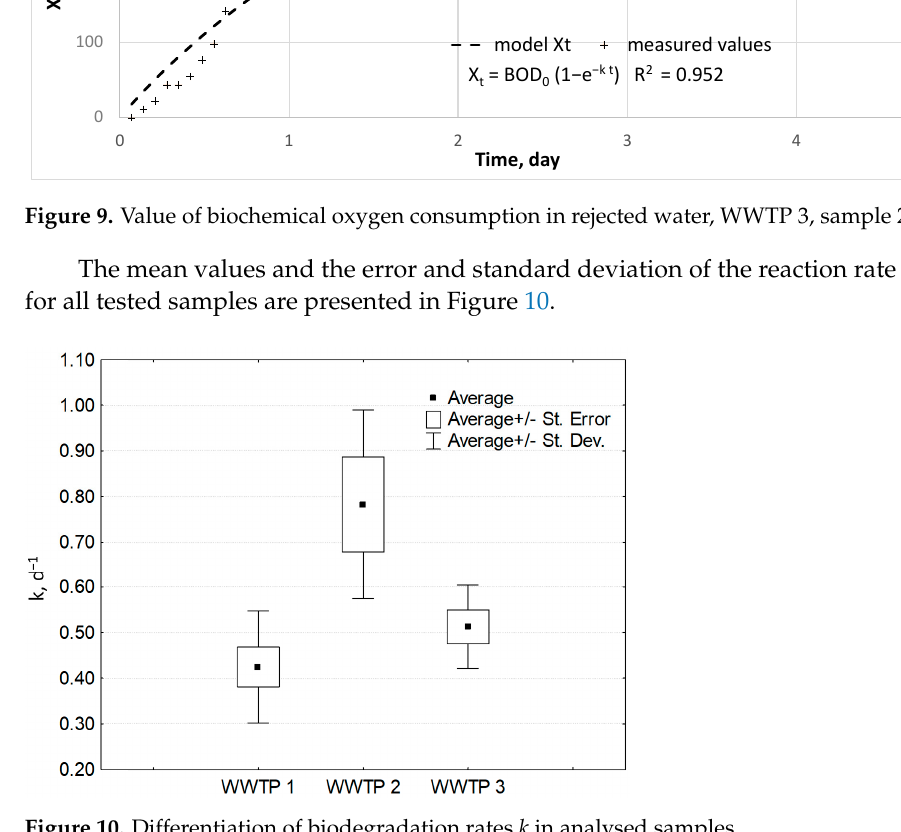
Figure 10. Differentiation of biodegradation rates k in analysed samples.